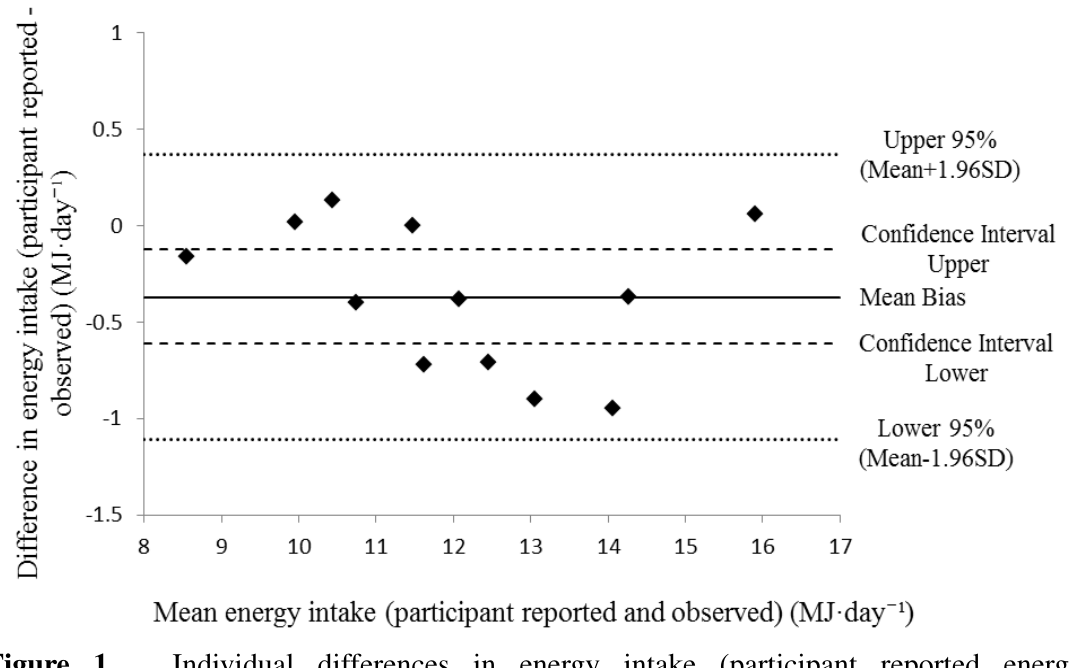
Figure 1. Individual differences in energy intake (participant reported energy intake − observed energy intake) plotted against the mean of the measurements for energy intake.